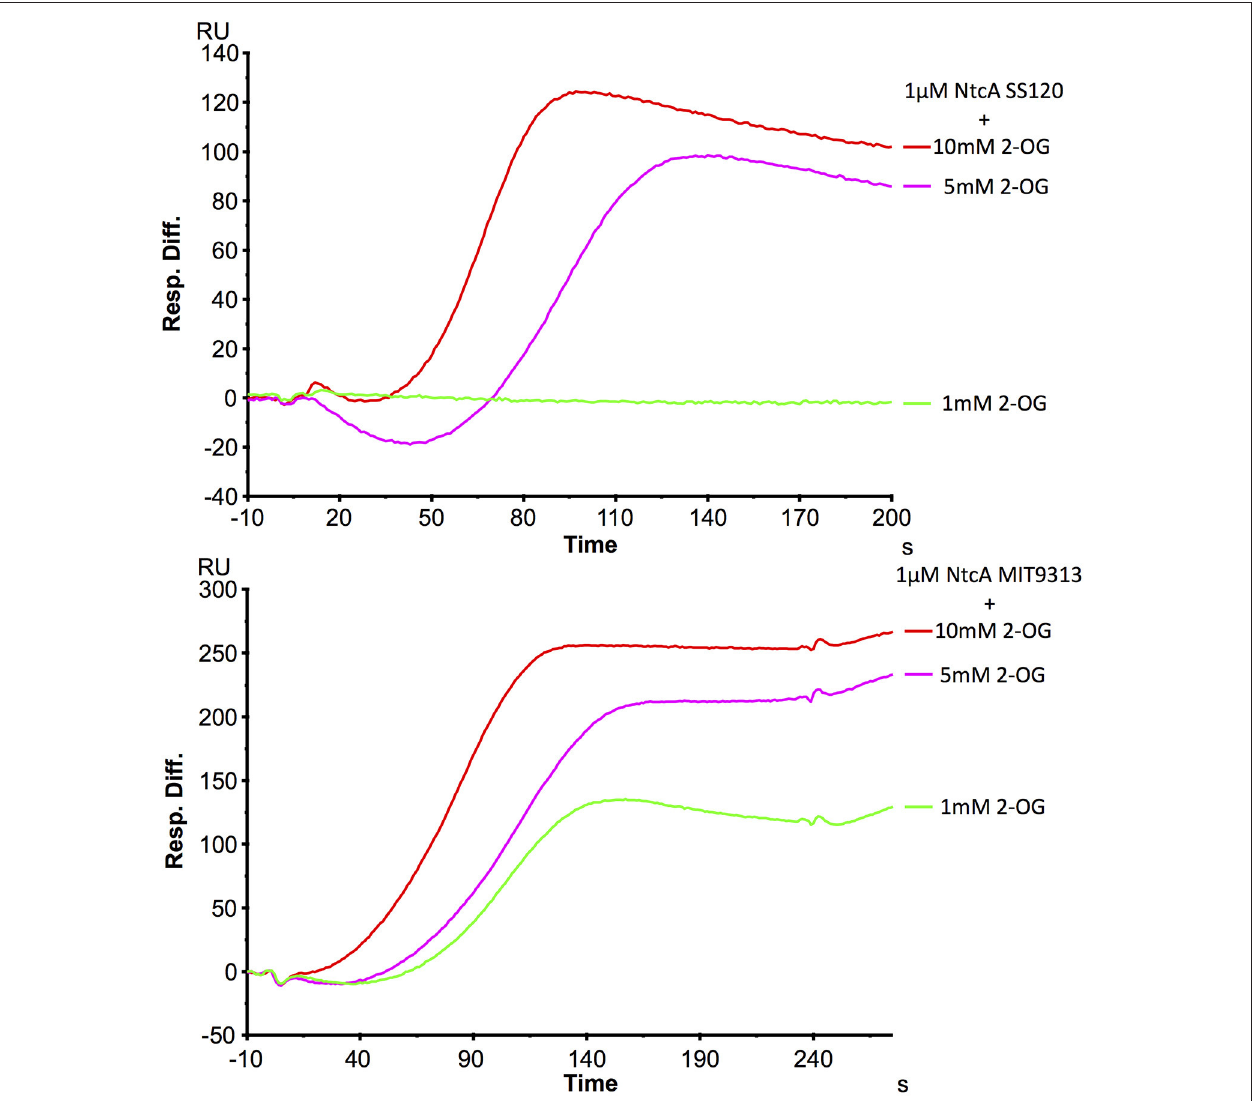
FIGURE 5 | SPR analysis of the interaction between NtcA(His) 6 and the promoter for glnA in Prochlorococcus sp. SS120 and MIT9313. This sensorgram shows the interaction of 1 µ M of NtcA(His) 6 with wild-type glnA promoter DNA and a rising concentration of 2OG. Relative units show the signal difference from FC2 ( glnA ) and an unspecific oligonucleotide coupled to the reference cell FC1. 1 µ M NtcA was used in all assays, in the presence of 1mM (green), 5mM (pink), and 10mM (red)